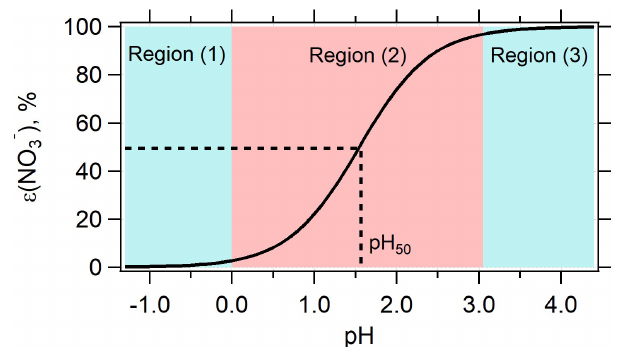
Figure 1. Predicted particle-phase fraction of total nitrate, ε (NO − ), 3 versus pH for 1-year average condition in Cabauw based on Eq. (2). The blue-color zone denotes where HNO 3 –NO − (nitric acid– 3 nitrate) partitioning is not affected by changes in pH, while the red-color zone shows the region where adjusting pH will change HNO 3 –NO − partitioning and hence NO − concentration. NO − is 3 3 3 most sensitive to pH at ε (NO − ) = 50%, which corresponds to a pH 3 defined as pH 50